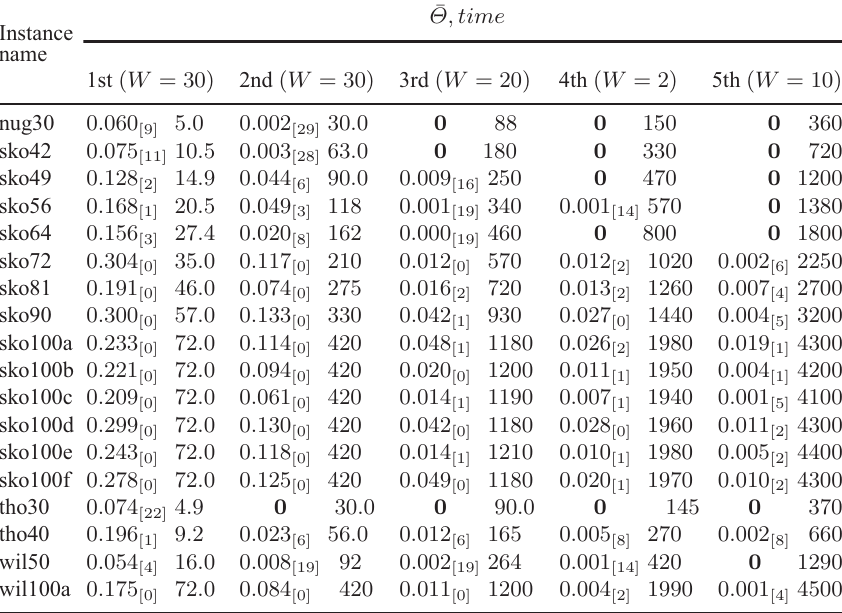
Table 2. Computational results of IH-SA-TS-QAP with the various numbers of iterations. The values of the average deviation ( ¯ Θ ) , and the CPU time (in seconds) are given. In addition, in parenthesis we give the numbers of times that BKV is